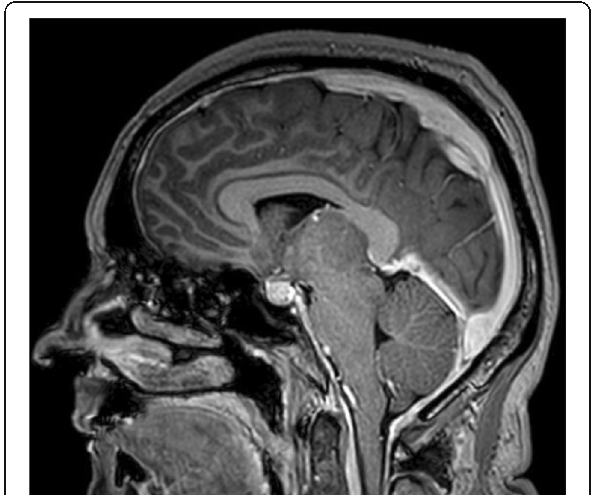
Fig. 1 (abstract P0358). See text for description